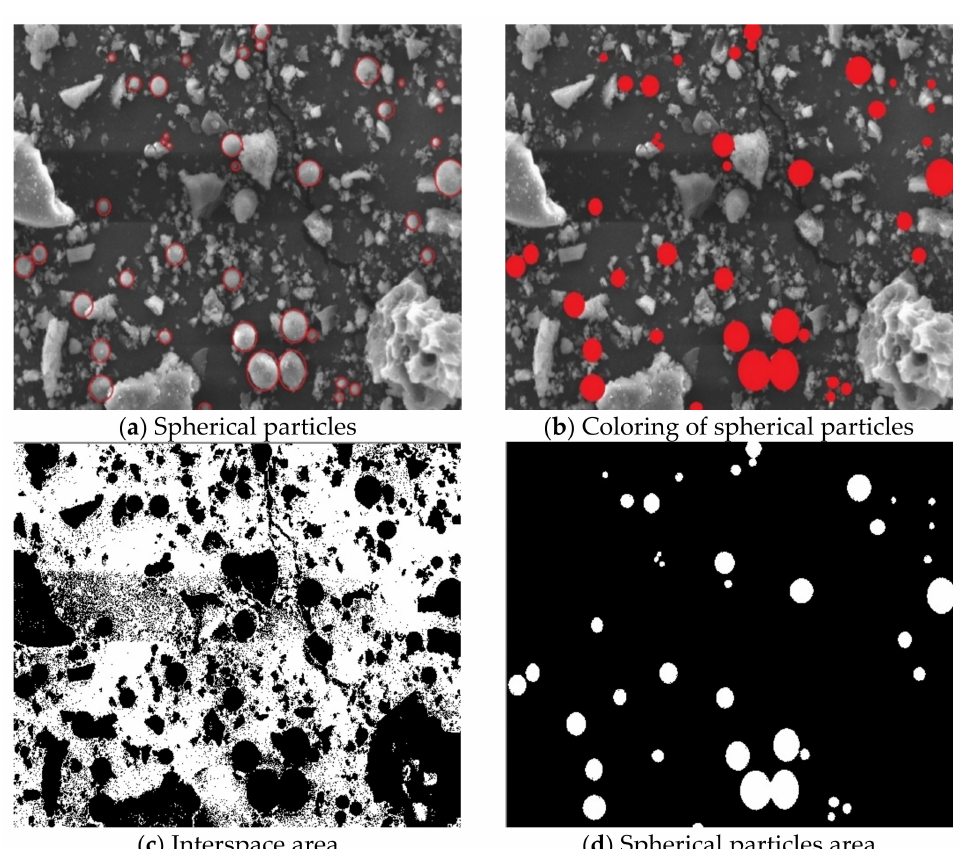
Figure 3. Area calculation in SEM images. ( a ) Spherical particles. ( b ) Coloring of spherical particles. ( c ) Interspace area. ( d ) Spherical particles